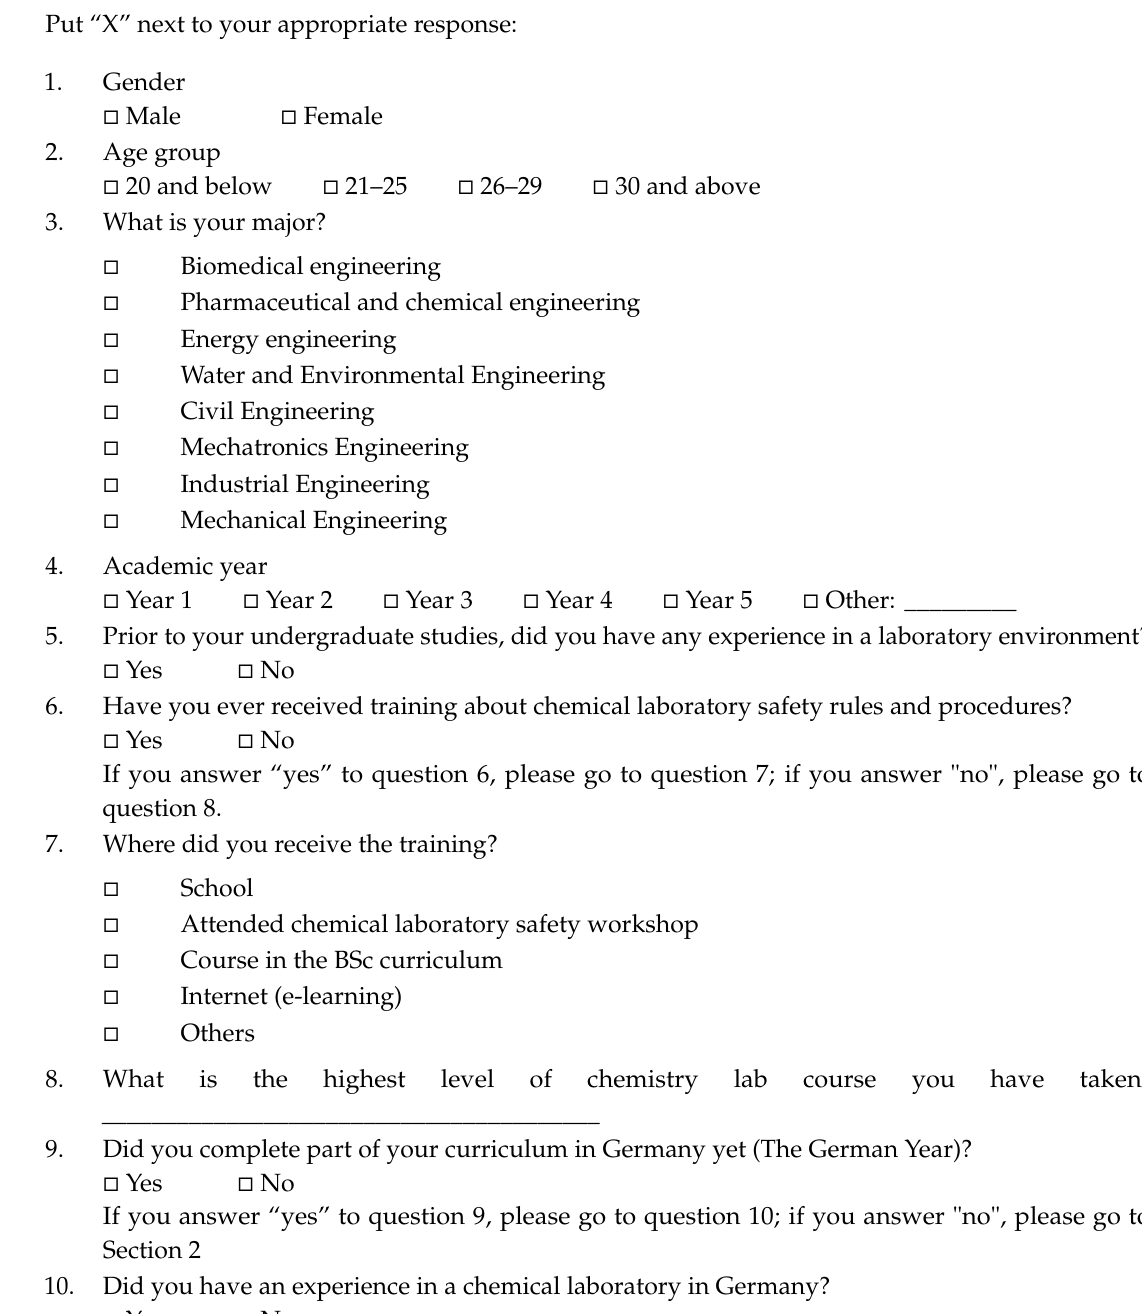
Section 2: Assessment of Familiarity and Understanding of Chemical Hazard Warning Signs Match hazard warning symbol (column A) with the corresponding description of the chemical property it represents (column B). If you do not know what the symbol represents, then put “X” in the box beside “I don’t know what this symbol